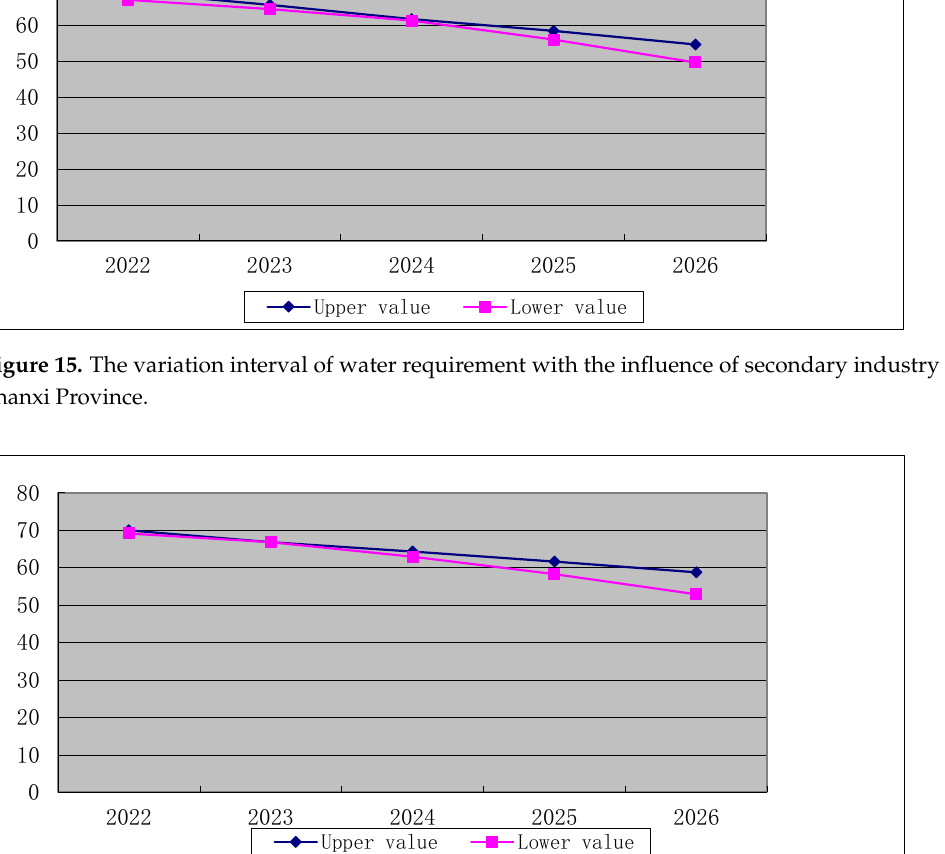
Figure 16. The variation interval of water requirement with the influence of the tertiary industry in Shanxi Province.